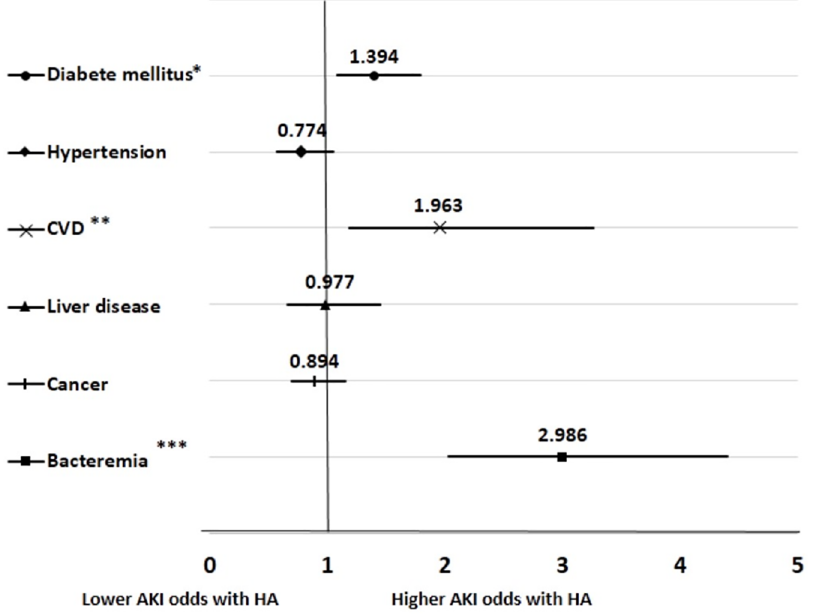
Fig 3. Forest plot of the odds ratio for AKI development in the multivariate logistic regression model. The odds ratio is adjustedfor all covariablesin Table 1. * P- interaction < 0.05, ** P- interaction < 0.01, and *** P- interaction < 0.001. AKI, acute kidney injury; CVD, cardiovascular disease;HA, hypoalbuminemia. Error bars indicate95% confidenceintervals.